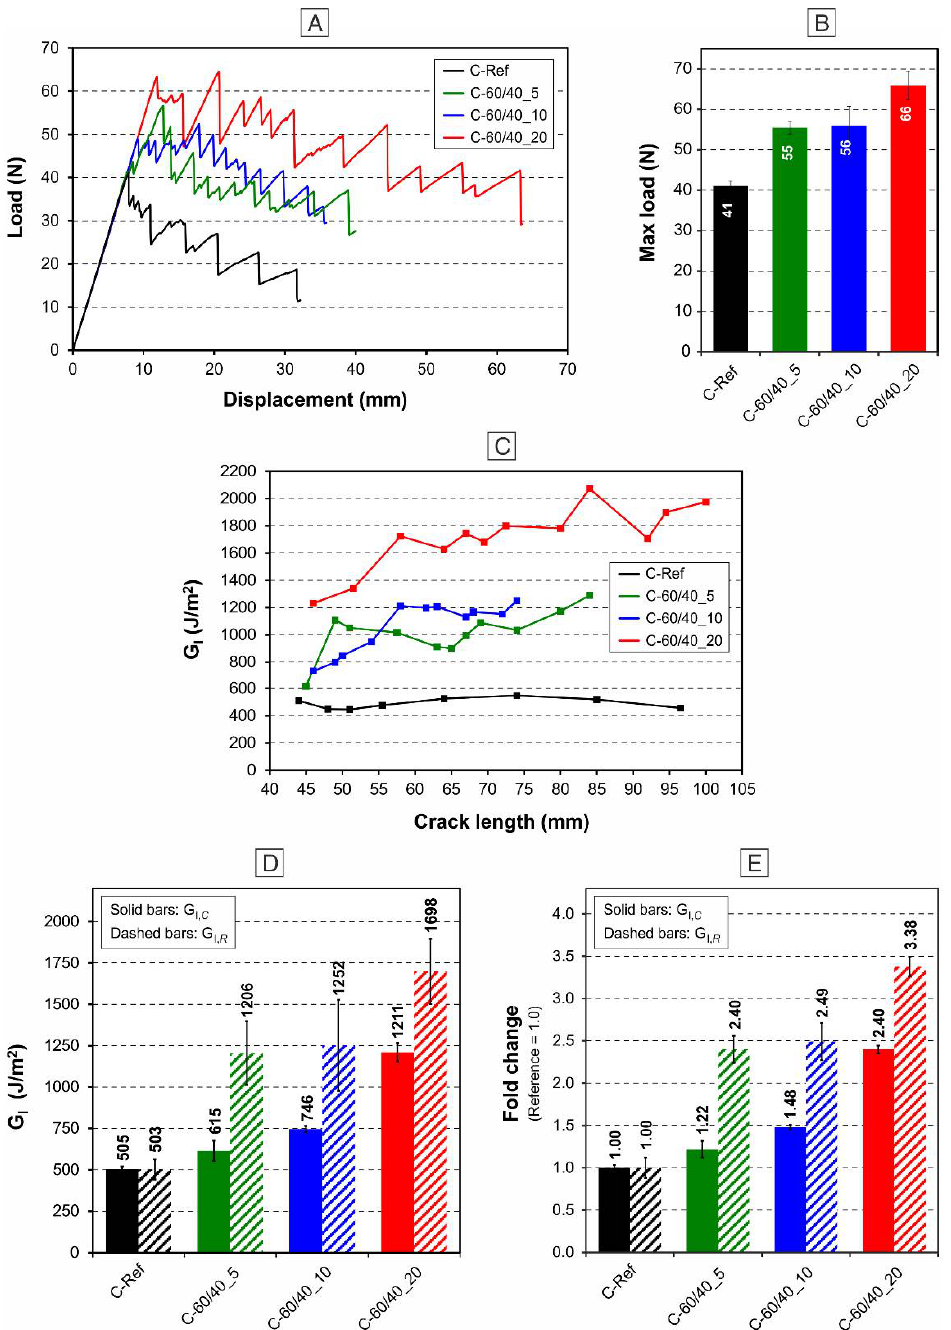
Figure 13. DCB tests results: ( A ) load–displacement curves; ( B ) maximum load; ( C ) R -curves related to the same specimens displayed in ( A ); ( D ) average G I, C and G I, R ; ( E ) G I fold change (bars are expressed as the relative variation of the value with respect to the reference sample (C-Ref), whose value is set as 1.0).